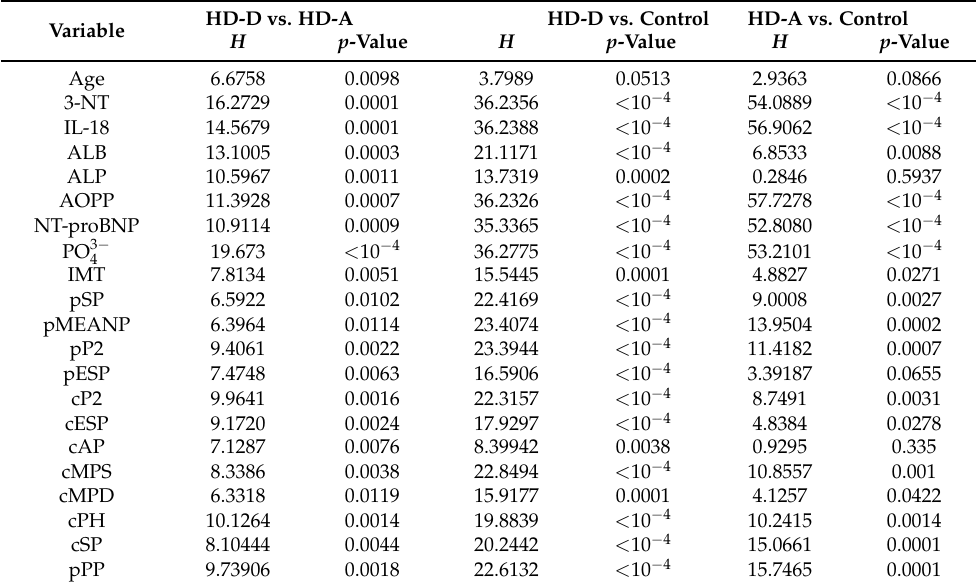
Table 2. Significant differences for HD-A vs. HD-D (calculated Kruskal–Wallis H > H critical ( 5.991 ) on proper level of significance p ≤ 0.05), with additional comparison to existing (or not) dissimilarities to the control group (HD-D vs. Control and HD-A vs.